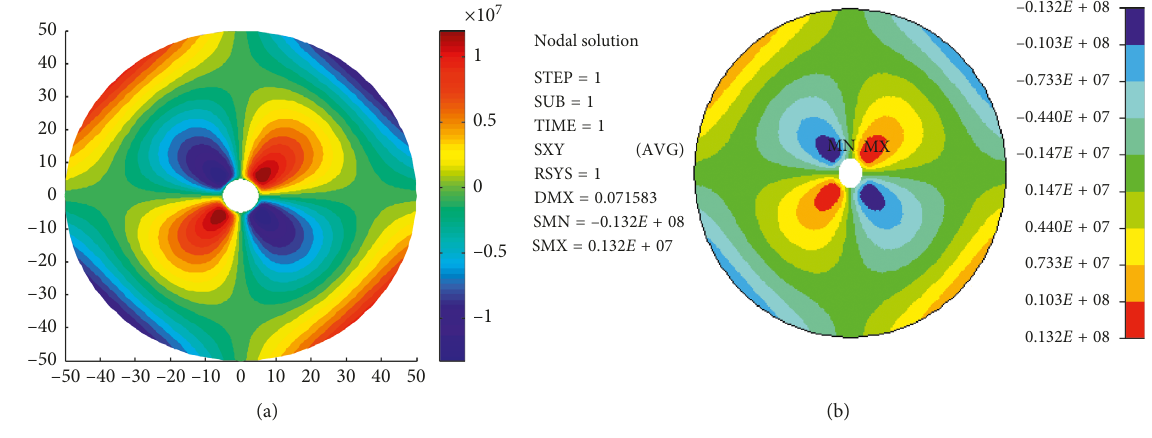
Figure 7: Cloud diagram of the shear stress τ around the hole corresponding to different m values (unit: φ